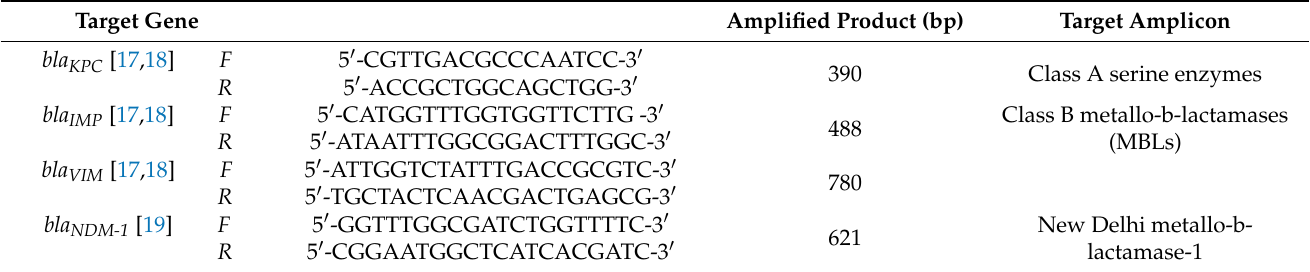
Table 1. List of the primers used for amplification of carbapenemase genes in the isolated Enterobacteriaceae .